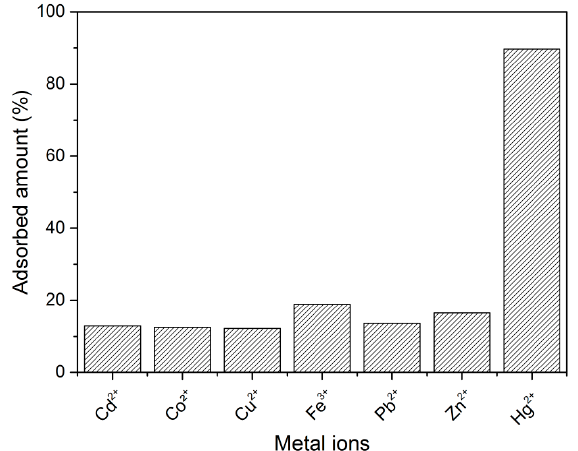
Figure 3. Comparison of the adsorbed percentage of metal ions after one hour of treatment with blended poly(SDIB)/PMMA fibers. Aqueous metal ion solutions were 0.7 mM and mixed with 1 mg material per mL solution.